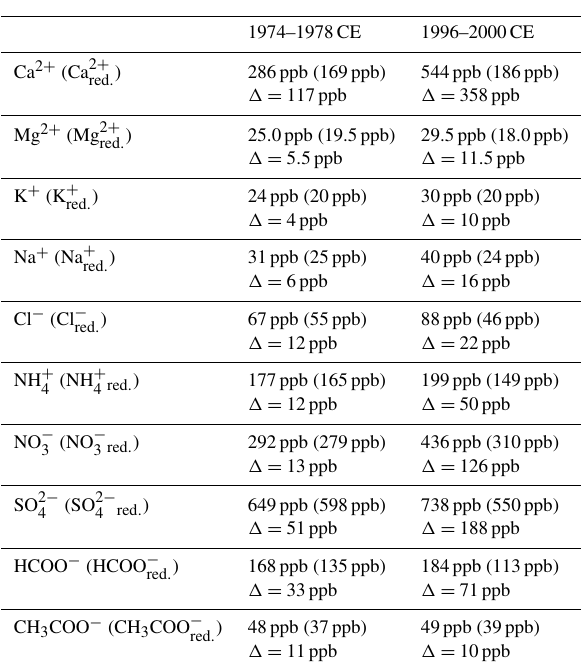
Table 2. Mean chemical composition of snow layers deposited in periods characterized by low and high dust inputs (1974–1978 and 1996–2000, respectively). Values in parentheses are mean values calculated after removal of samples containing dust (denoted red.). (cid:49) refers to the difference between total and dust-reduced (red.) val- ues (i.e., [ X ]−[ X red . ] for the X